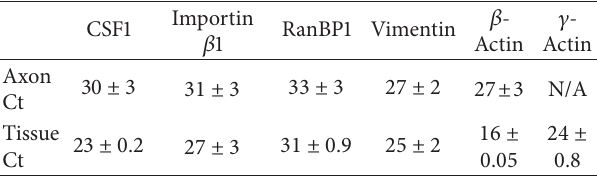
Table 2: RT-PCR validates the presence of importin 𝛽 1, RanBP1, vimentin, 𝛽 -actin,and 𝛾 -actininexplantlysatesandrevealsdifferent levels of transcripts in explants and axons. In addition, 𝛾 -actin is absent from axons (Ct values of > 37). Values represent Ct values.